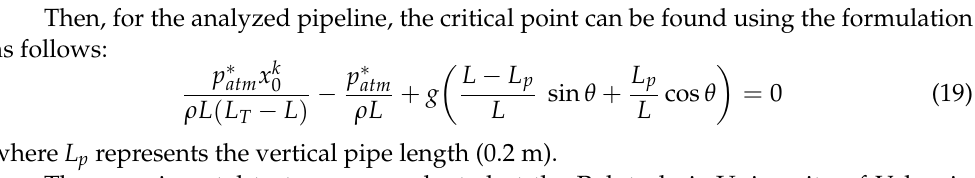
Figure 6. Experimental facility .